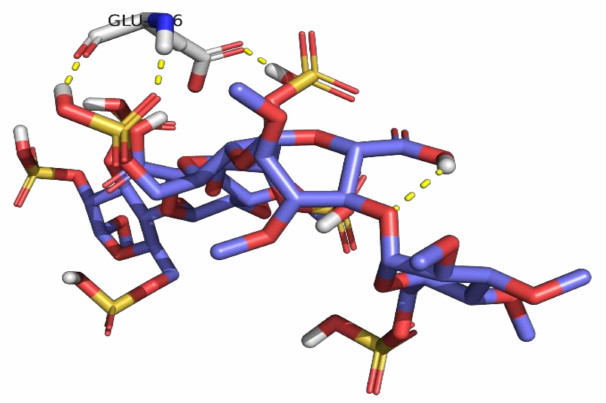
Figure 7. Hydrogen bond interactions between the protein residue (Glu166) and